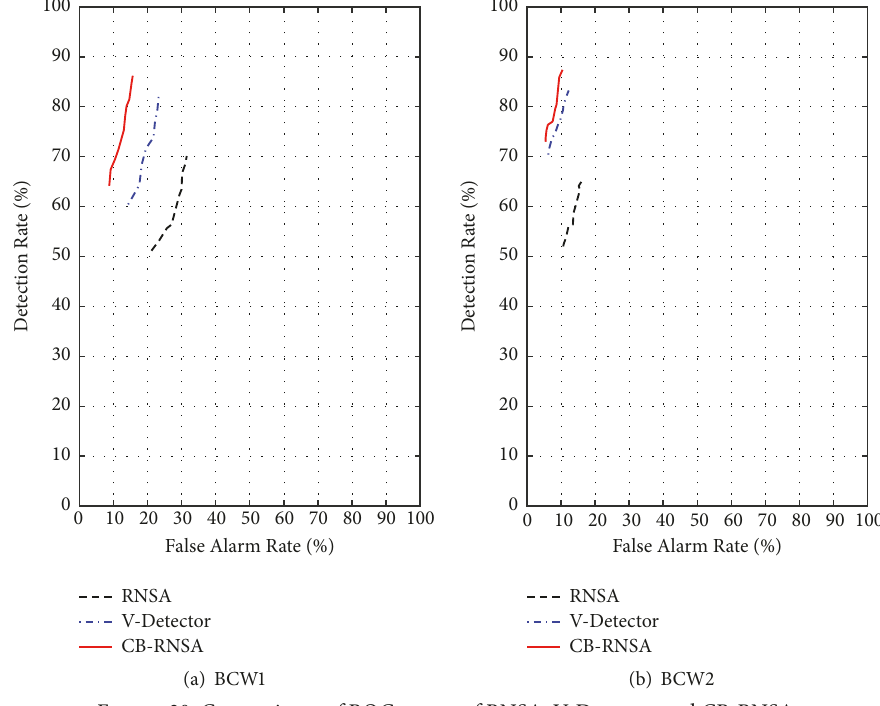
Figure 20: Comparisons of ROC curves of RNSA, V-Detector, and